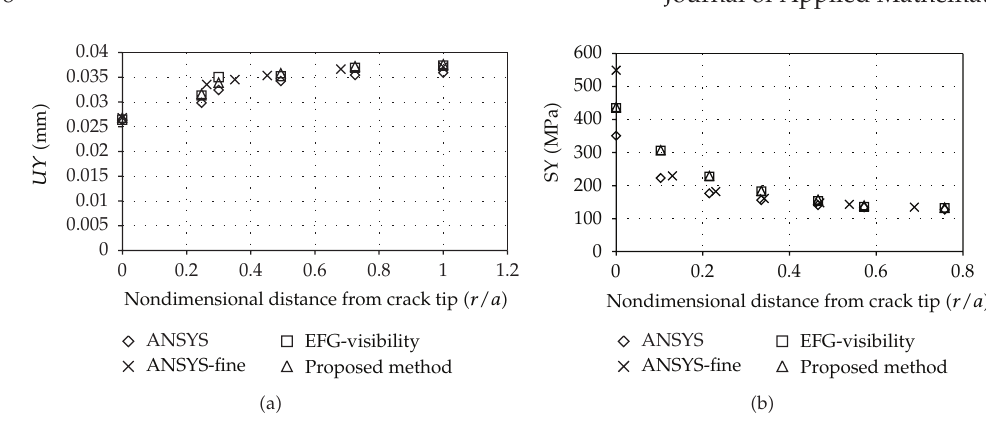
Figure 5: (cid:2) a (cid:3) Opening of crack face (cid:2) b (cid:3) Vertical stress near the crack tip for MT specimen with a/ W (cid:11) 0 .